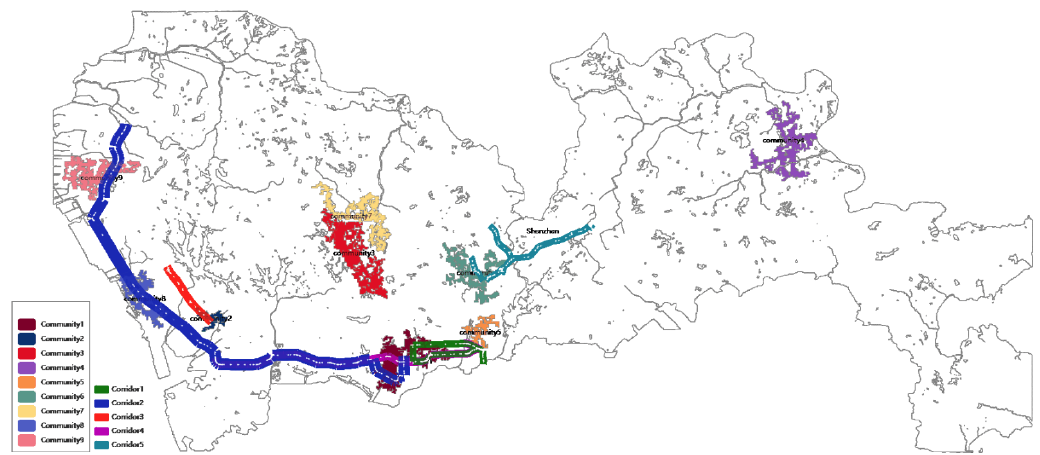
Figure 11. Discovered corridors and mobility communities for 11:00AM–1:00PM on weekdays.